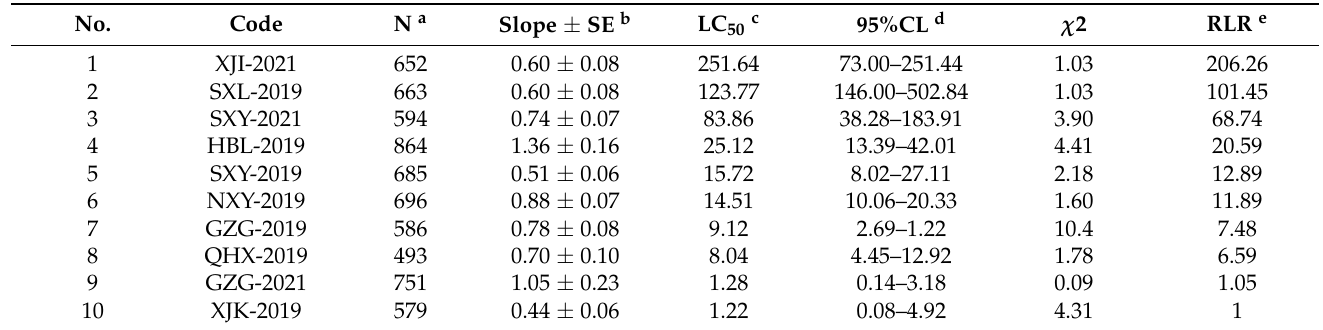
Table 3. Toxicity of sulfoxaflor to Metopolophium dirhodum field